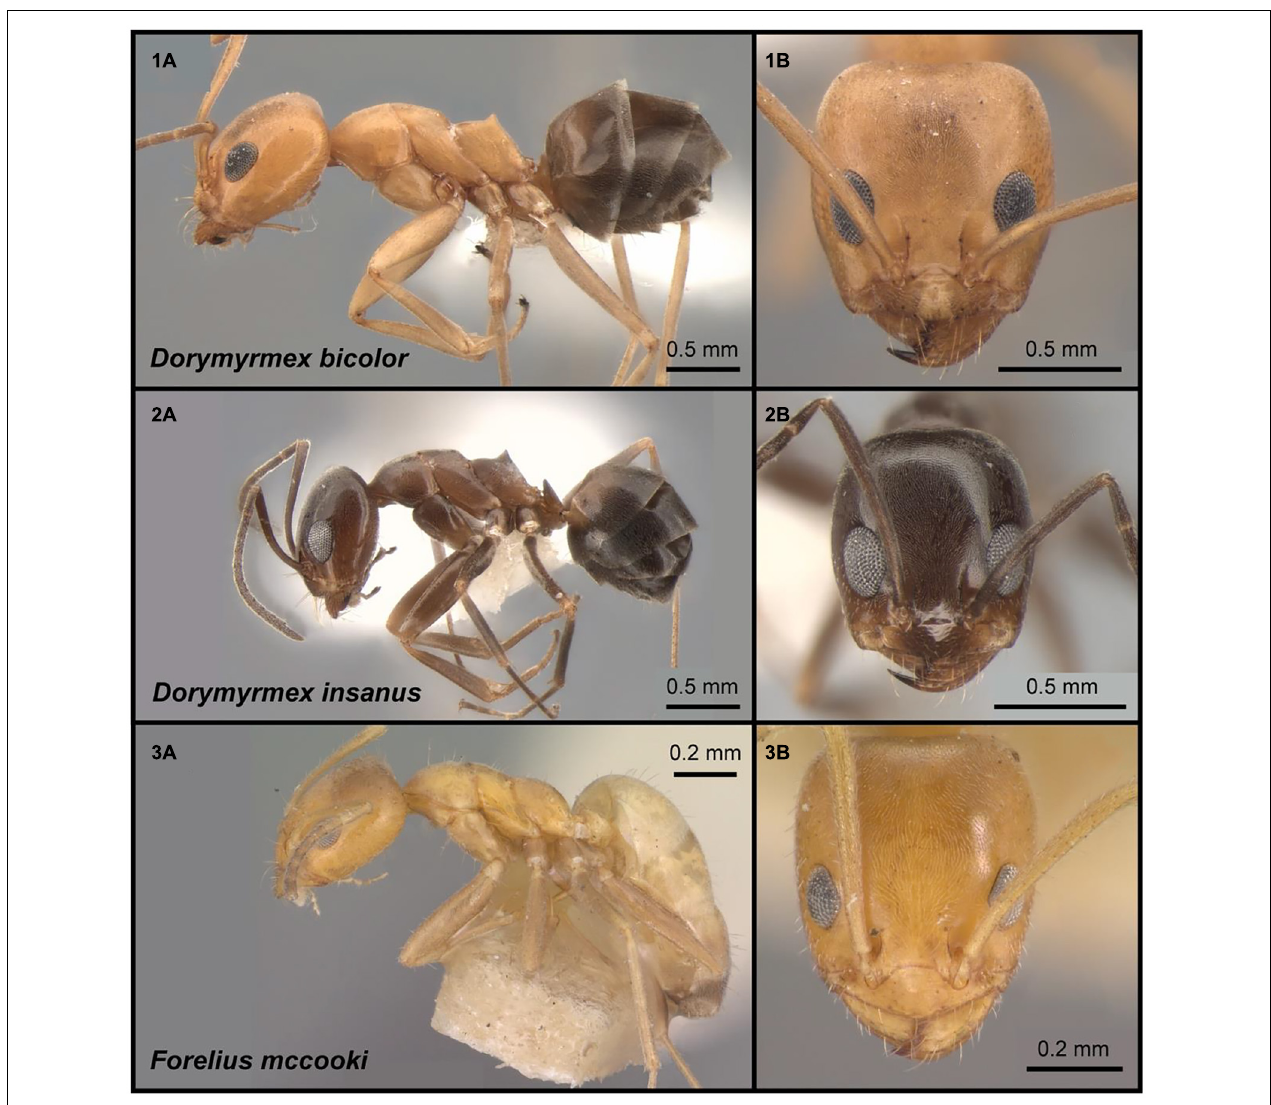
FIGURE 1 | Three sympatric species of dolichoderine ants at the focus of the present work. (1A,B) Dorymyrmex bicolor , specimen CASENT0841125. (2A,B) Dorymyrmex insanus , specimen CASENT0841126. (3A,B) Forelius mccooki , specimen CASENT0102754. Complete specimen data and images are hosted on AntWeb (www.antweb.org); photographers Jill Oberski (1,2), Jen Fogarty